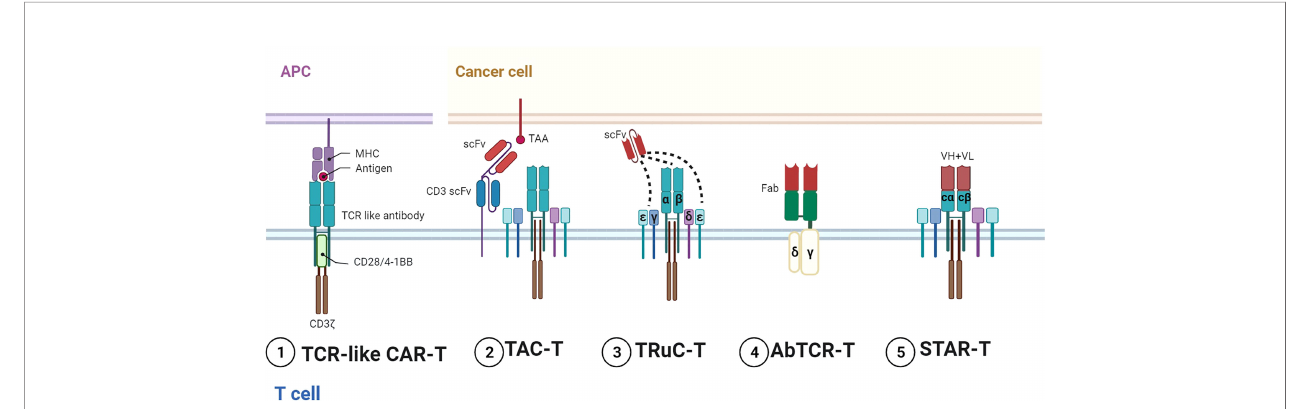
FIGURE 2 | Representative designs of TCR – CARs. Diagrams of TCR – CARs with different con fi gurations for tumor antigen recognition and cell activation. 1) TCR-like CAR-T utilized TCR-like antibodies for recognition and conventional stimulatory domains for activation. 2) TAC-T combined TCR with speci fi c TAAs by two scFvs. 3) TRuC T bound scFvs to different parts of TCR and CD3. 4) AbTCR-T incorporated Fabs and gd TCR. 5) STAR-T contained VH and VL with TCR-C a / b . Figure created using